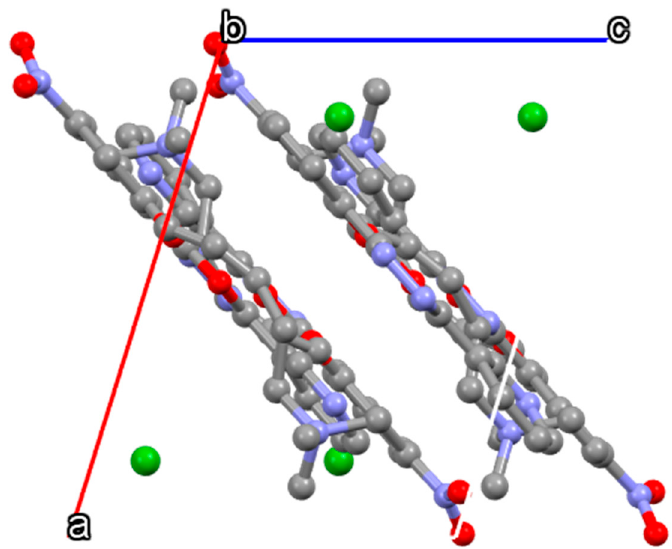
Figure 3. Crystal packing of C1•Br along b axis direction.